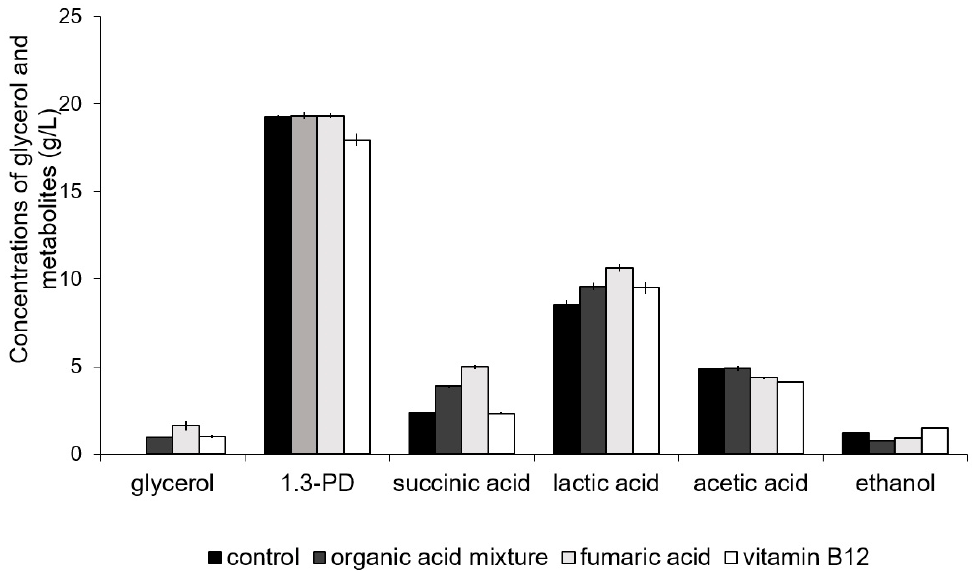
Figure 7. Effect of the addition of organic acids and vitamin B 12 on metabolite production and glycerol utilization by C. freundii AD119.